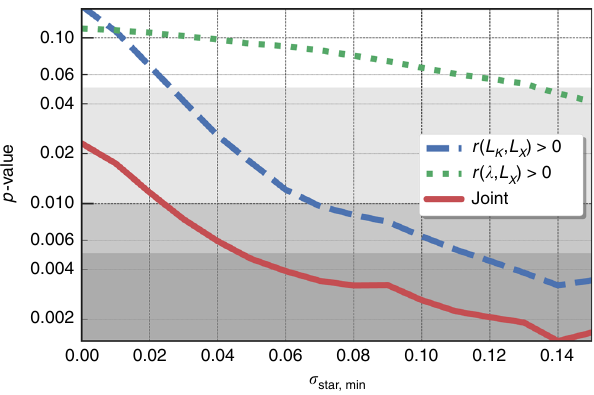
Fig. 3 Odds that the stellar – L X correlation is positive as a function of the minimum imposed stellar mass scatter. The blue dashed and green dotted lines shows the odds for stellar mass proxies of L K and λ , respectively. The red solid line shows the odds of having a positive correlation coef fi cient for both stellar mass proxies and L X . The light gray, gray, and dark gray shaded regions show respectively the regions with <5%, <1%, and <0.5% odds of having a positive or zero